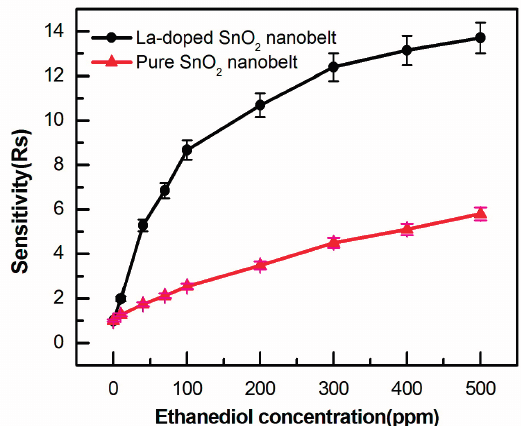
Figure 6. The gas sensitivity of two devices to ethanediol from 5 ppm to 500 ppm at 230 °C.